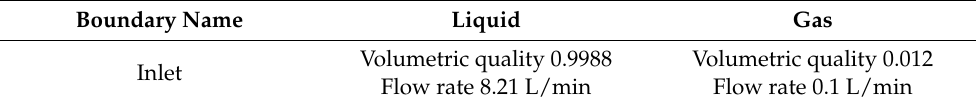
Table 3. Boundary conditions for baseline